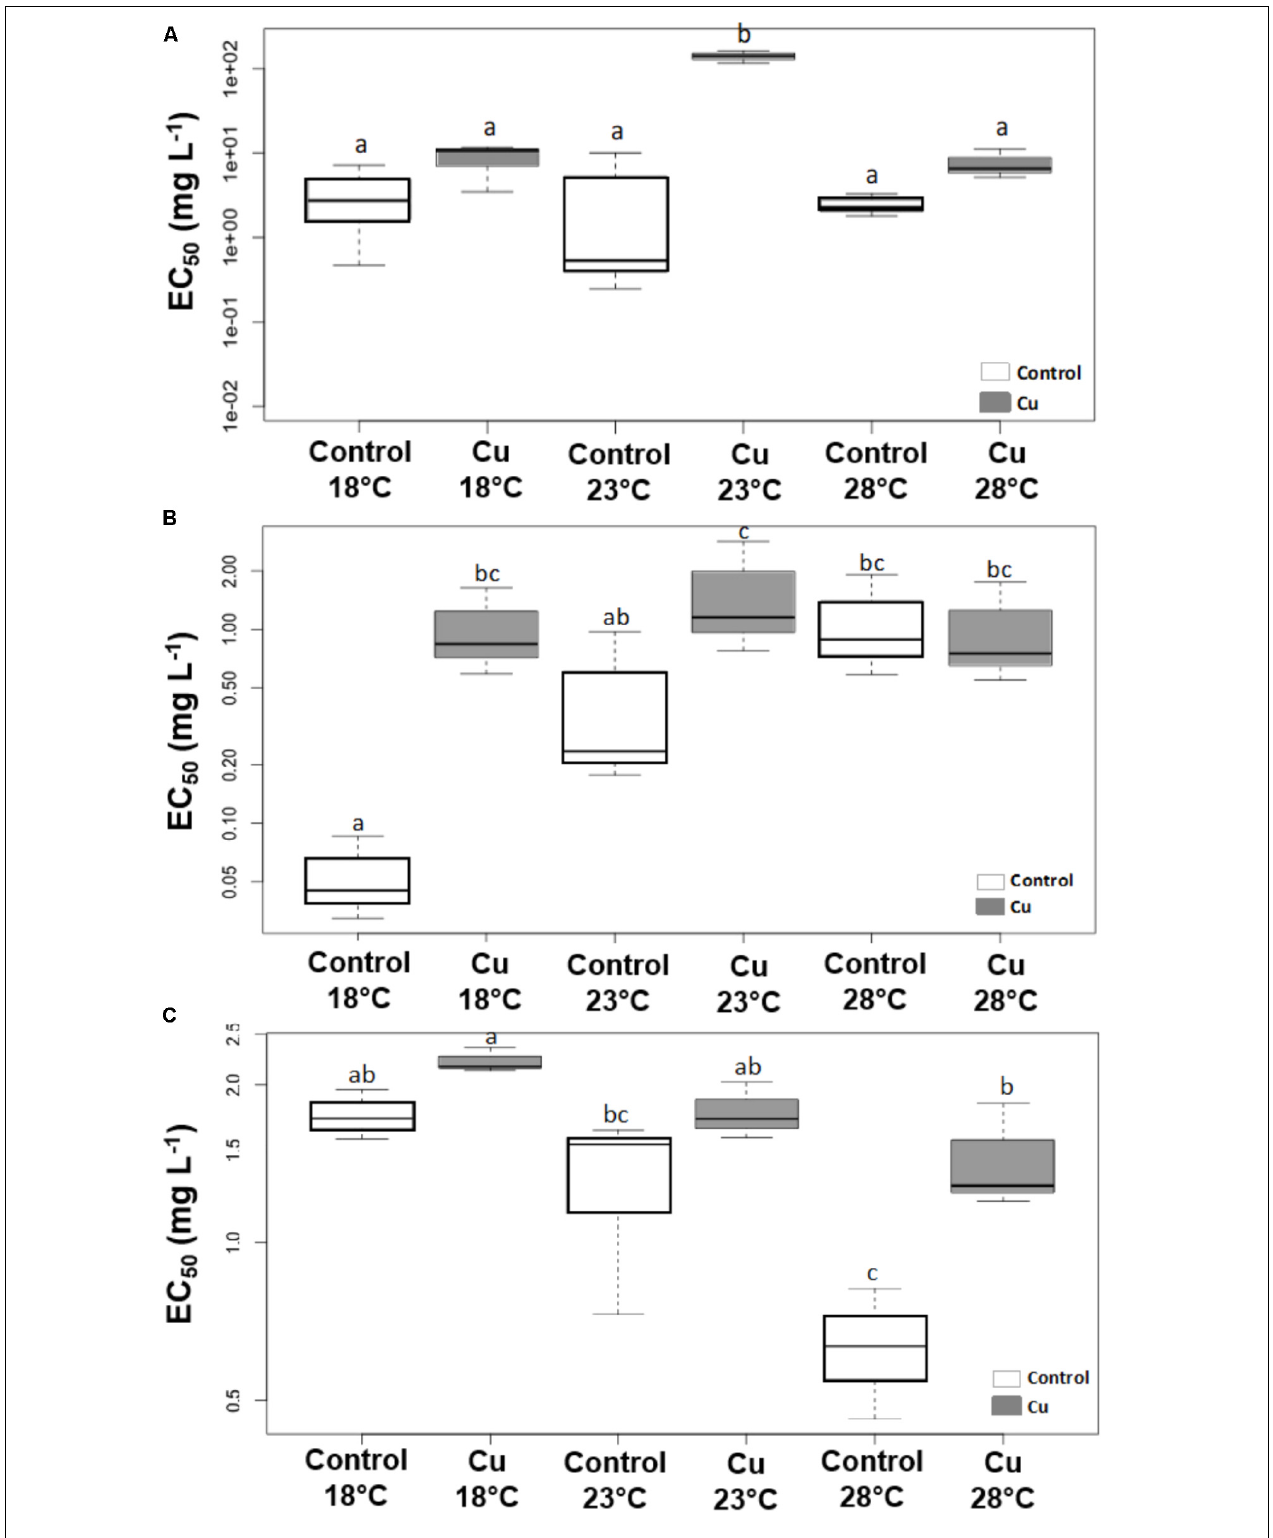
FIGURE 4 | Boxplot of EC 50 values (mg Cu L − 1 ) determined at week 4 for phototrophic communities based on photosynthetic yield (A) and for heterotrophic communities based on β -glucosidase (B) and Leucine aminopeptidase (C) activities. The horizontal line represents the median. The upper and lower limits of the box represent the 75th and 25th percentiles. Different letters indicate significant differences between treatments (ANOVA, p < 0.05, n = 3).